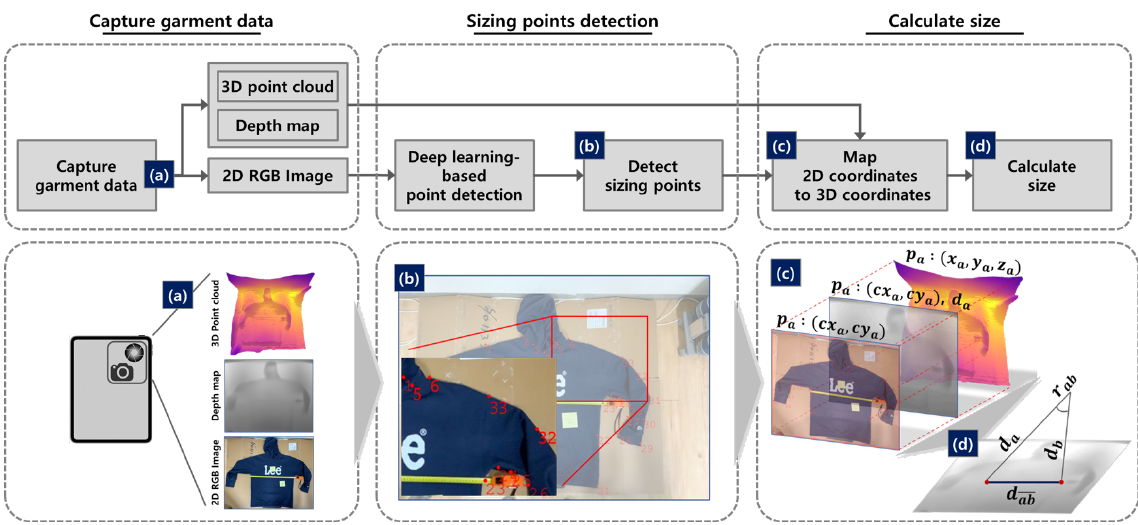
Figure 1. Three steps of the automatic garment size measurement approach. ( a ) We used a mobile device equipped with cameras and a LiDAR sensor to collect images and point clouds of clothes taken from the same viewpoint. ( b ) The deep learning-based point detector detects the two-dimensional coordinates in the picture of the measurement points. ( c ) The points p a in the depth map are in 2D coordinates ( cx a , cy a ) that match the RGB image, and each has a distance d a from the sensor. ( d ) Finally, the program calculates the size d with d a and d b and the angle r ab between two ab